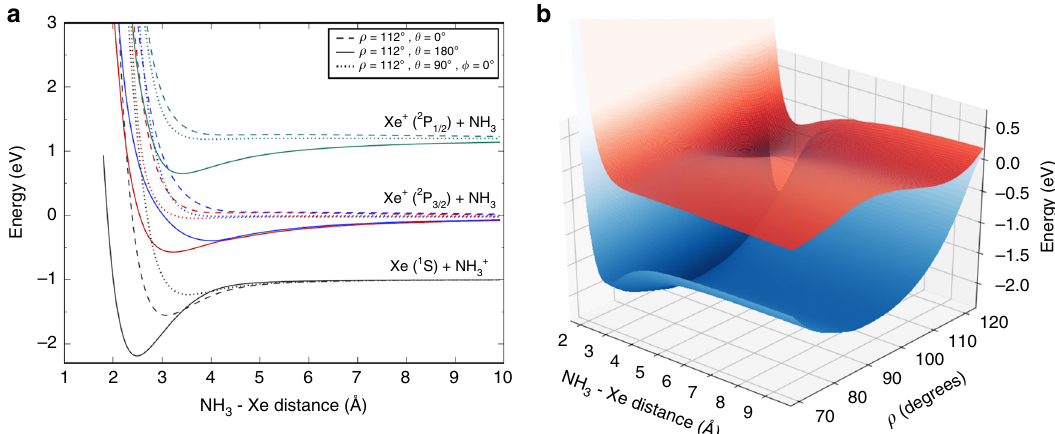
Fig. 4 Potential energy surfaces. a A series of one-dimensional cuts are plotted as a function of the distance R between Xe and the center of mass of NH 3 , for the four PESs of the [Xe – NH 3 ] + complex that are relevant to the charge transfer process. Each of the PESs is plotted in a different colour. Three different angles of approach are shown for each surface, with the umbrella angle fi xed to the equilibrium value of NH 3 , ρ ¼ 112 (cid:6) . The preferred orientation ( θ ¼ 180 (cid:6) ) corresponds to Xe þ approaching the N atom end of ammonia along its symmetry axis. (Please see the “ Methods ” section for further details.) b PESs of the two lowest molecular states, shown for the most favourable orientation ( θ ¼ 180 (cid:6) ) and plotted as a function of R and ρ . The upper surface corresponds to the Xe þ + NH reactants (the entrance channel), with the lower surface representing the Xe þ NH þ products (the exit channel). In 3 3 the upper PES, the double well of NH 3 is seen to be strongly perturbed by the presence of the Xe þ ion. At large umbrella angles, the two surfaces become almost